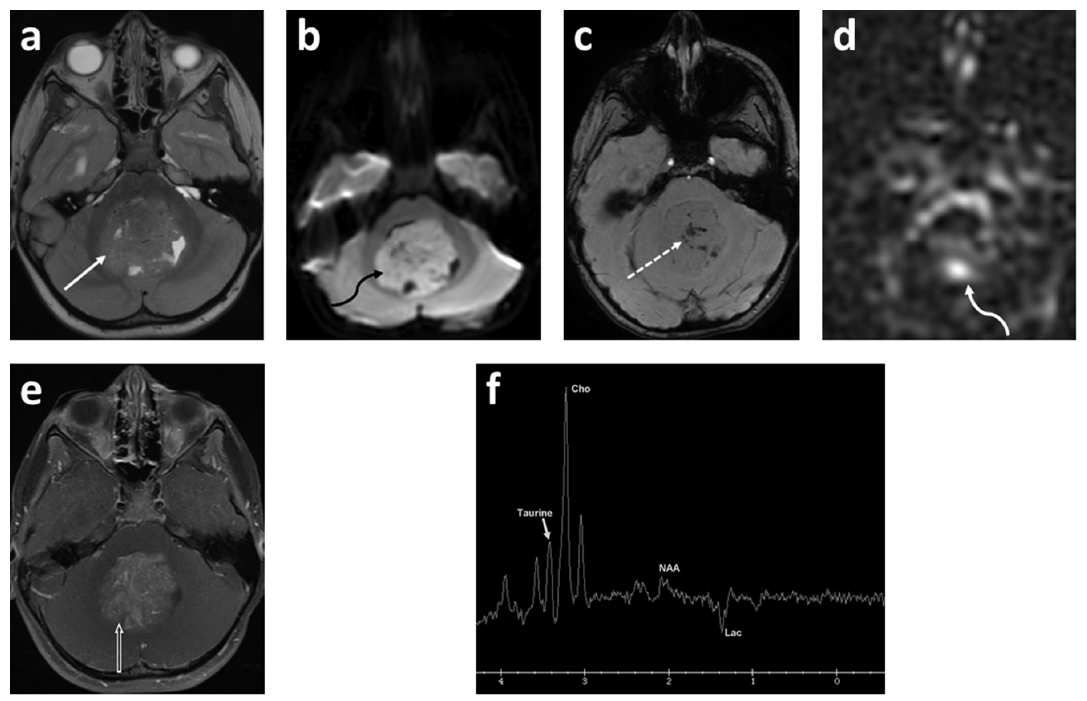
Figure 1. Five-year-old female presented with headache, vomiting and gait disturbance. Axial T2 ( a ); axial DWI ( b ); axial SWAN ( c ); axial ASL-PWI ( d ); axial T1 fat saturated post contrast ( e ) images; and long TE (144 msec) spectroscopy ( f ). There is a large heterogeneous, intermediate T2 signal mass centered in the fourth ventricle (solid white arrow). This mass demonstrates restricted diffusion (curved black arrow) with numerous punctate foci of the hemorrhage (dashed arrow) and increased perfusion (curved white arrow) in the center of the lesion. There is moderate heterogeneous enhancement after contrast ministration (open arrow). Spectroscopy demonstrates Taurine peak at 3.4 ppm, high choline (Cho) and undetectable N-acetylaspartate (NAA). There is also high lactate (Lac) demonstrated as an inverted peak on this long TE spectroscopy. Final diagnosis was medulloblastoma, Group